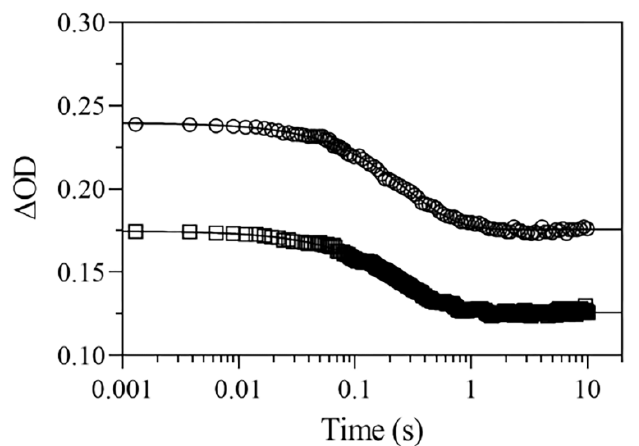
Figure 4. CO dissociation from Mt -Nb(II)-CO (circles) and Hs -Nb(II)-CO (squares) by NO replacement, λ = 421 nm, pH 7.0 and 25.0 ◦ C. The CO and NO concentration was 5.0 × 10 − 4 M and 1.0 × 10 − 3 M, respectively. The continuous lines were obtained according to Equation (1) with values of k off(CO) reported in Table 1 R -squared values for CO dissociation from Mt -Nb(II)-CO and Hs -Nb(II)-CO are 0.997 and 0.996, respectively.